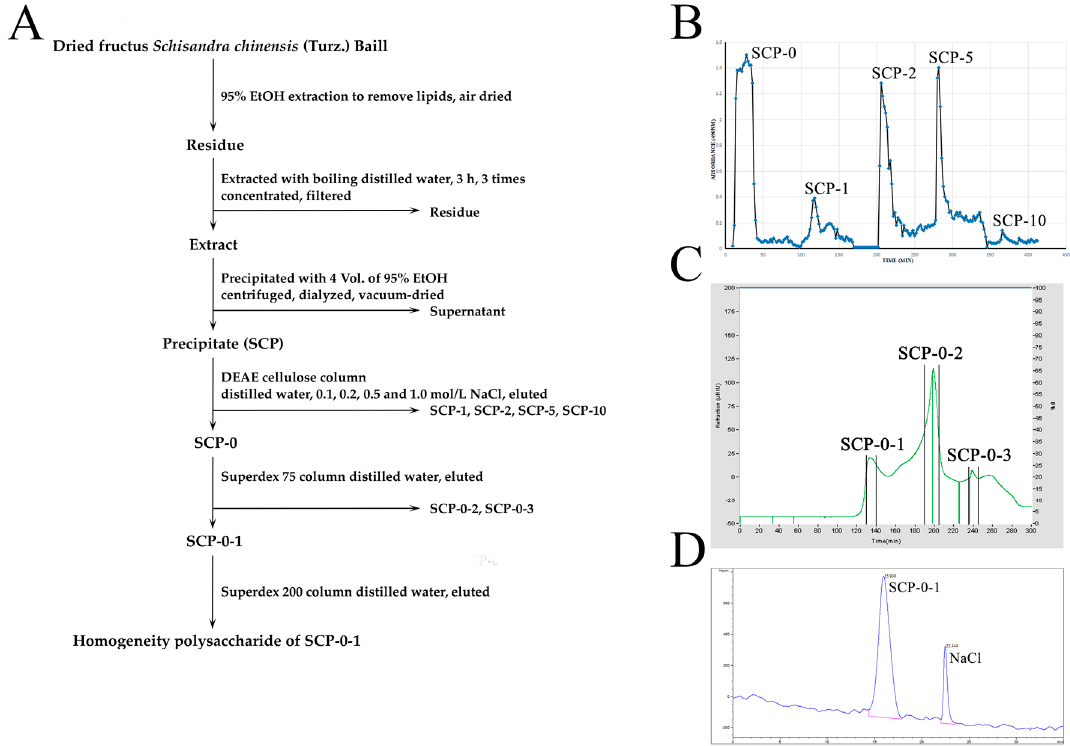
Figure 1. Flow diagram of isolation and purification of homogeneous S. Chinensis polysaccharide (SCP-0-1) from fructus S. chinensis (Turz.) Baill. ( A ) The dried fructus S. chinensis were defatted with EtOH, and extracts were obtained by boiling in distilled water; the extract was obtained and then precipitated to gain fructus S. chinensis . After continuous separation via diethylaminoethyl (DEAE)-cellulose anion-exchange chromatography and Superdex 75 and 200 gel permeation chromatography, the carbohydrate fraction SCP-0-1 was obtained; ( B ) The eluted curve of polysaccharides from S. Chinensis polysaccharides (SCP) was fractionated on a DEAE-cellulose column (50 × 5 cm, Cl − form) and eluted with distilled water and different gradients of NaCl at 1.0 mL/min; ( C ) The eluted curve of SCP-0 fractionated on a Superdex 75 column (SCP-0-1: 130–140 min, SCP-0-2: 190–205 min, and SCP-0-3: 235–245 min); ( D ) The eluted curve of SCP-0-1 in HPGPC. The sample was analysed by a Shodex series-connected KS-804 and KS-802 gel filtration column (30 cm × 7.8 mm) and eluted with 0.2 mol/L NaCl at 0.8 mL/min.